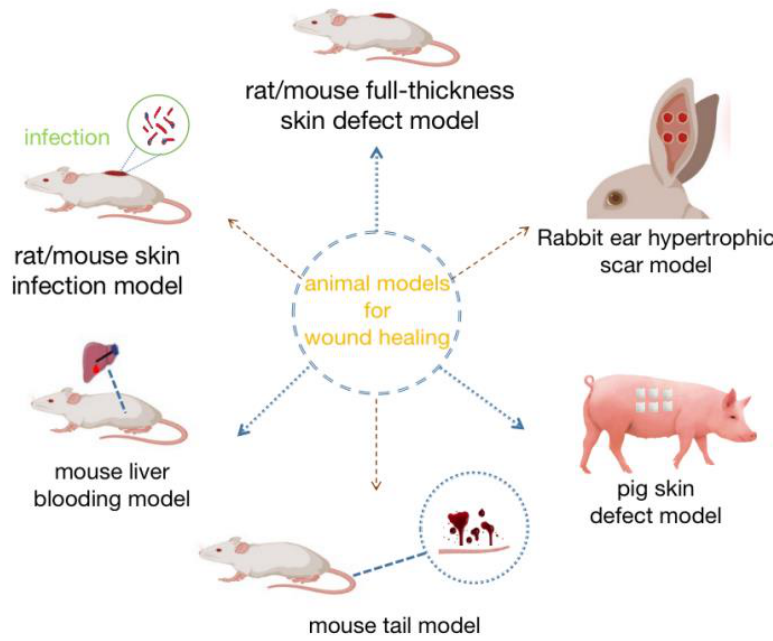
Figure 2. Animal models used in wound healing.